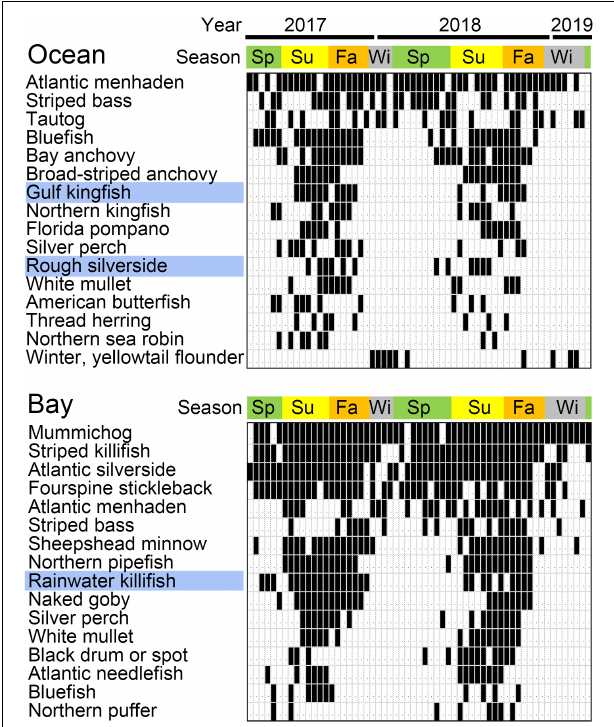
FIGURE 4 | Detection of selected bony fish species. Positive samples are indicated in black. Blue highlights fishes with new reference sequences reported in this study. Most seasonal species were restricted to warmer months, except for winter or yellowtail flounder ( Pseudopleuronectes americanus or Limanda ferruginea ), both cold water specialists.